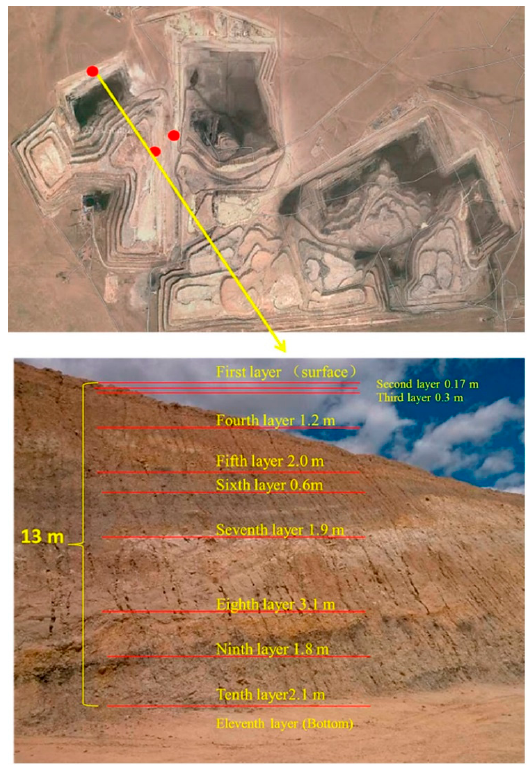
Figure 2. The distribution of soil sampling points and sections in the mining area [23].